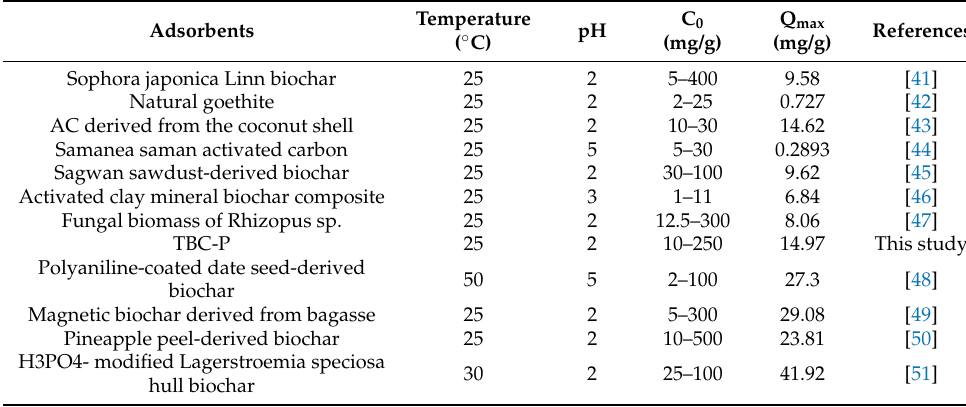
Table 5. Comparison of the adsorption capacities of various